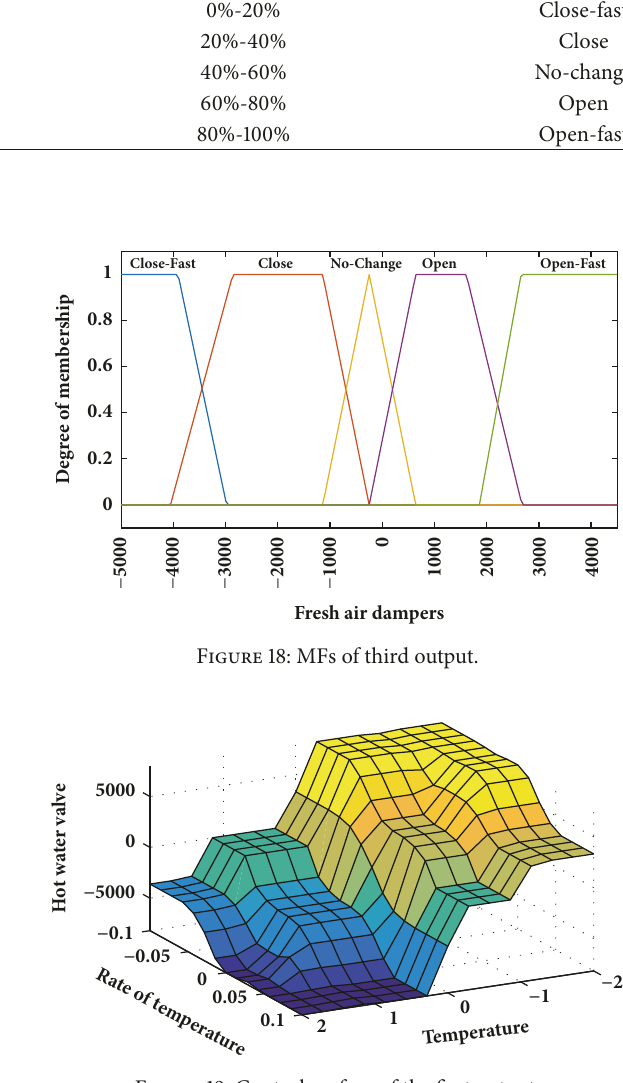
Figure 19: Control surface of the first